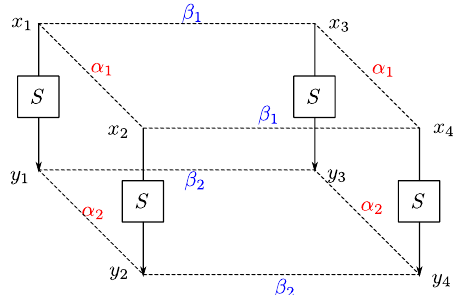
Figure 2: Differences of an S-box on four